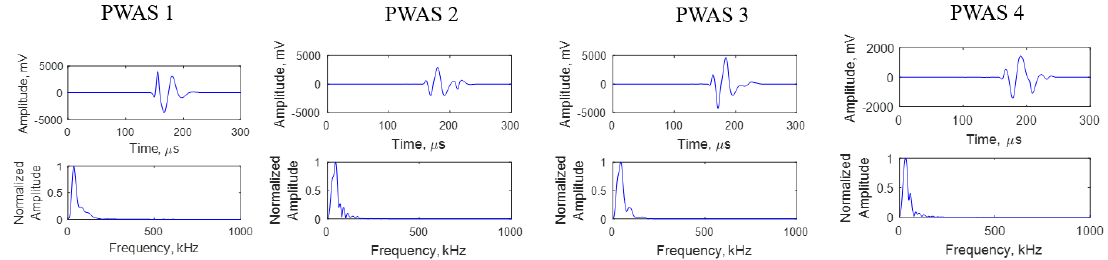
Figure 9. Signal correspondence at all four PWAS due to the 2nd impact hit.